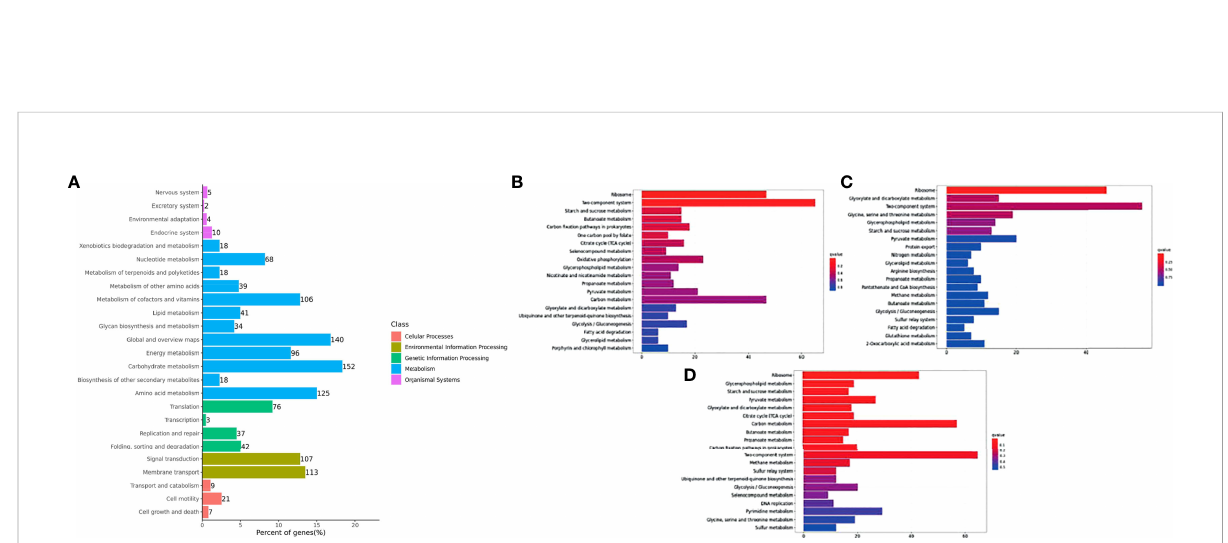
FIGURE 6 Histogram of the top 20 enriched KEGG pathways of DEGs in Y. ruckeri at different time points. The Y-axis represents the KEGG pathway categories. The X-axis represents statistical signi fi cance of the enrichment. (A) represents the classi fi cation of total KEGG, (B) represents the top 20 KEGG pathways in the C2_T6 group, (C) represents the top 20 KEGG pathways in the C2_T12 group and (D) represents the top 20 KEGG pathways in the C2_T24